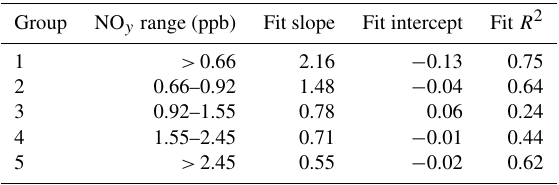
Table 1. Parameters associated with the NO y groupings of Fig. 6. Listed are the NO y concentrations and the parameters for least- squares linear fits to each group. R 2 represents the coefficient of determination.